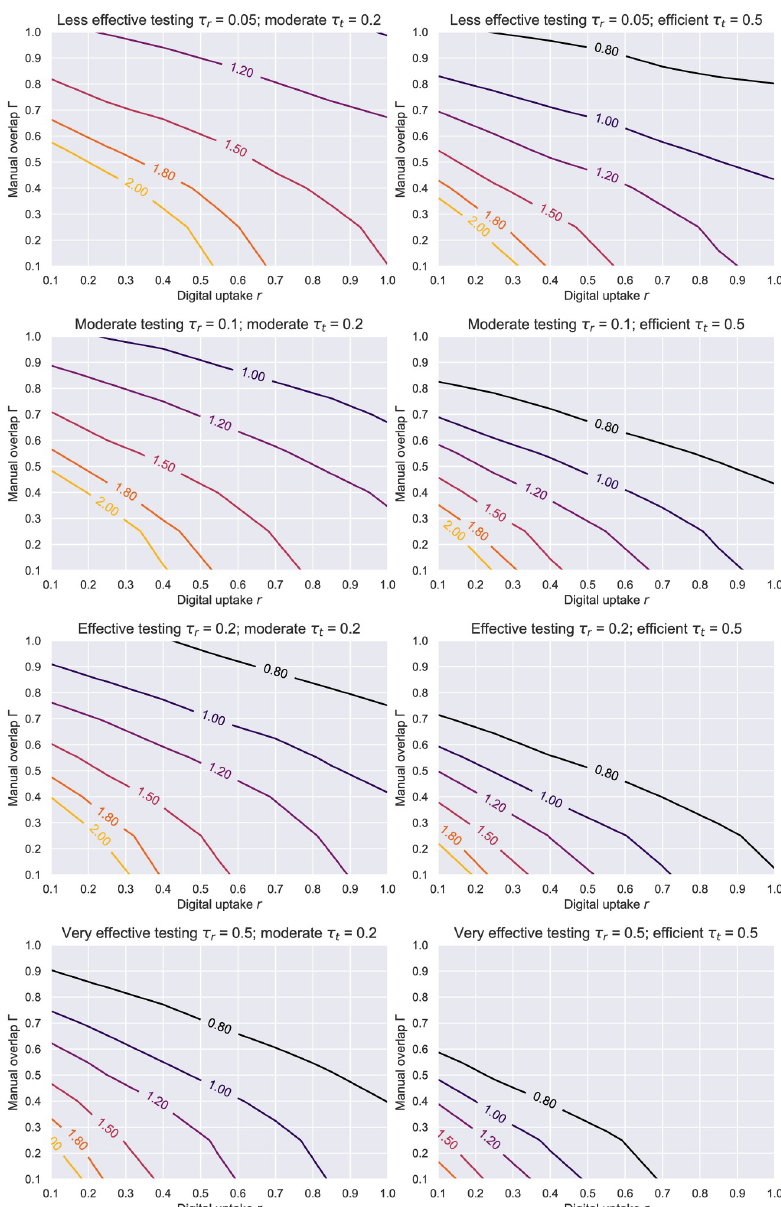
Fig 14. HK network—Contour plots of R based on the level of manual tracing overlap Γ and digital tracing uptake r . The results here are for a Holme-Kim network with N = 1000, m = 10, p 4 = 0.2, p a = 0.2, η = .001. Each line , while the columns correspond to a moderate (left) and efficient (right) average represents a different testing level τ r level of tracing engagement and isolation compliance given by τ t .